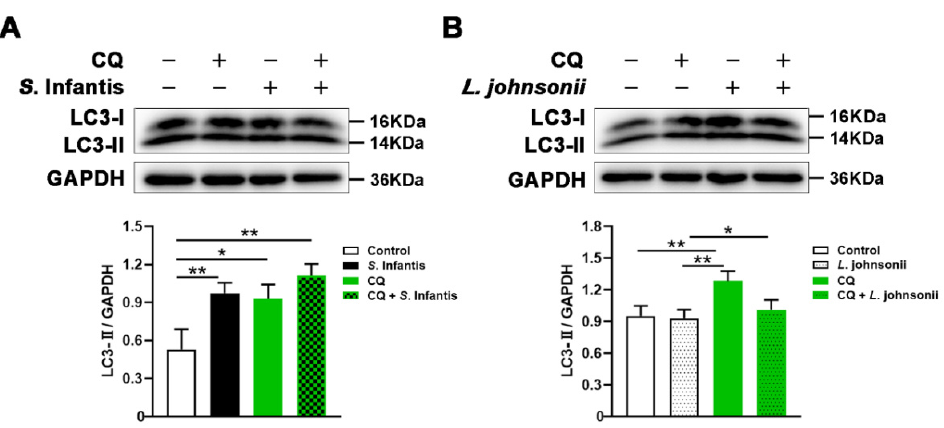
Figure 4. S. Infantis infection inhibits autophagy degradation of Caco2 cells, whereas L. johnsonii L531 accelerates this process. ( A ) Caco2 cells challenged with S. Infantis were pretreated with or without CQ. Western blotting analysis was conducted to detect the LC3 level. The lower panel shows the protein quantitation using Image J software. ( B ) Caco2 cells challenged with L. johnsonii L531 were pretreated with or without CQ. Western blotting analysis was conducted to detect the LC3 level. The lower panel shows the protein quantitation using Image J software. Data are represented as mean ± SEM, n = 3; * p < 0.05, ** p < 0.01, CQ, chloroquine.